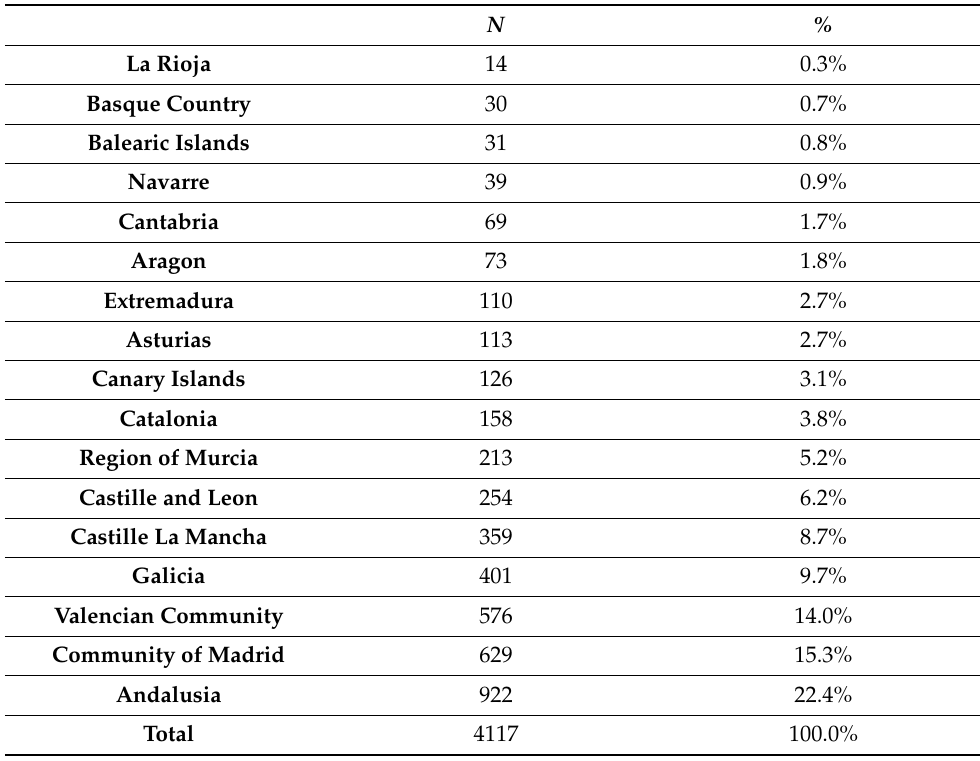
Table 1. Geographical distribution of